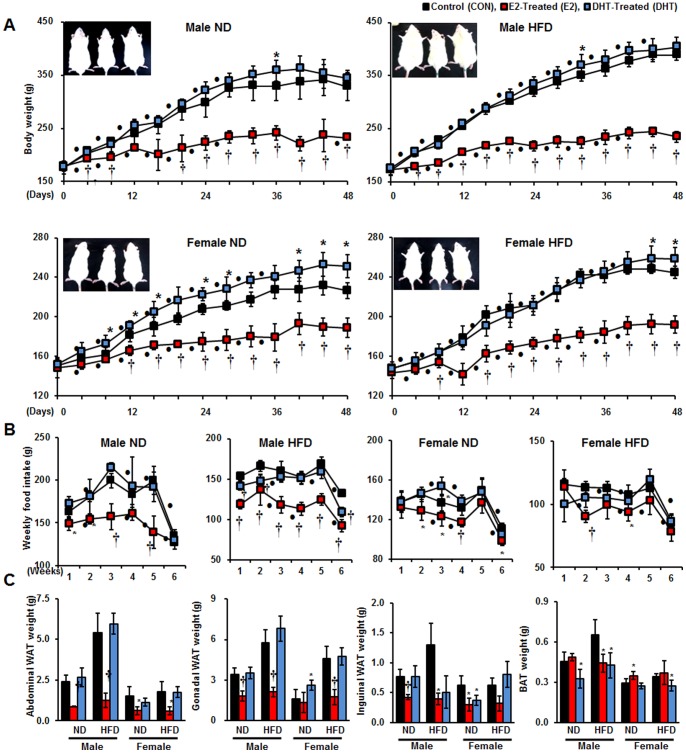
Dietary and hormonal effects on time-dependent body weight gain with whole body images (inside panels: control, E2-treated, and DHT-treated rats from left) of each group (A), weekly food intake (B), and weights of different adipose tissue depots (C).Statistical significance between control and hormone treated groups were calculated by Student’s t-test, where, *p<0.05 and †p<0.01. Significances between time dependent body weight gain and weekly food intake were calculated using repeated measures multivariate ANOVA, where • represents p<0.05.